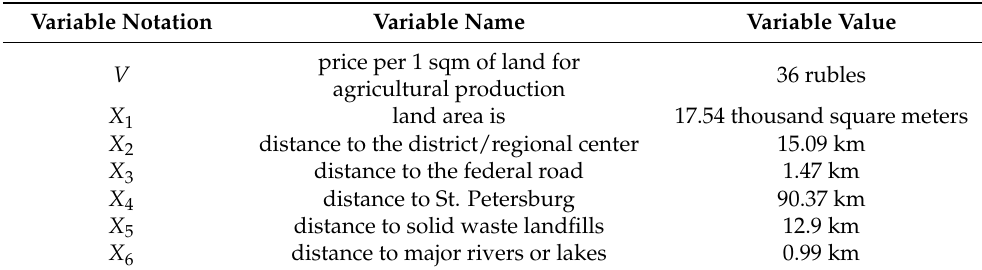
Table 2. Parameters to be used for the application of the theoretical model.